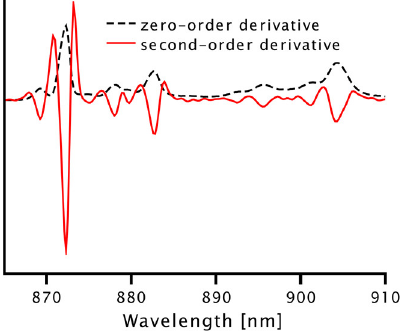
Figure 7. Zero-order (dashed line) and second-order derivative spectrum (solid line) of